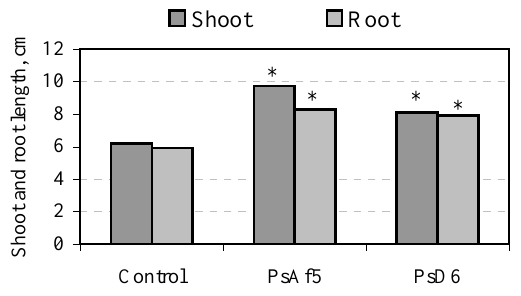
FIGURE 3 . Effect of Pseudomonas spp. on shoot and root length of tomato, P. denitrificans PsD6, and P. aureofaciens PsAf5. *Significant differences, p <